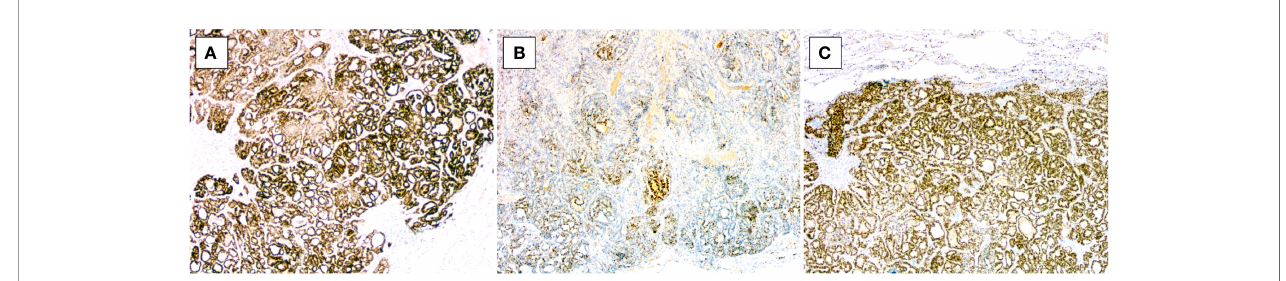
FIGURE 6 | Immunohistochemical fi ndings of metastatic MLA to the lung in case 3. The tumor cells are positive for (A) PAX8 (×40), (B) GATA3 (×40), and (C) TTF1